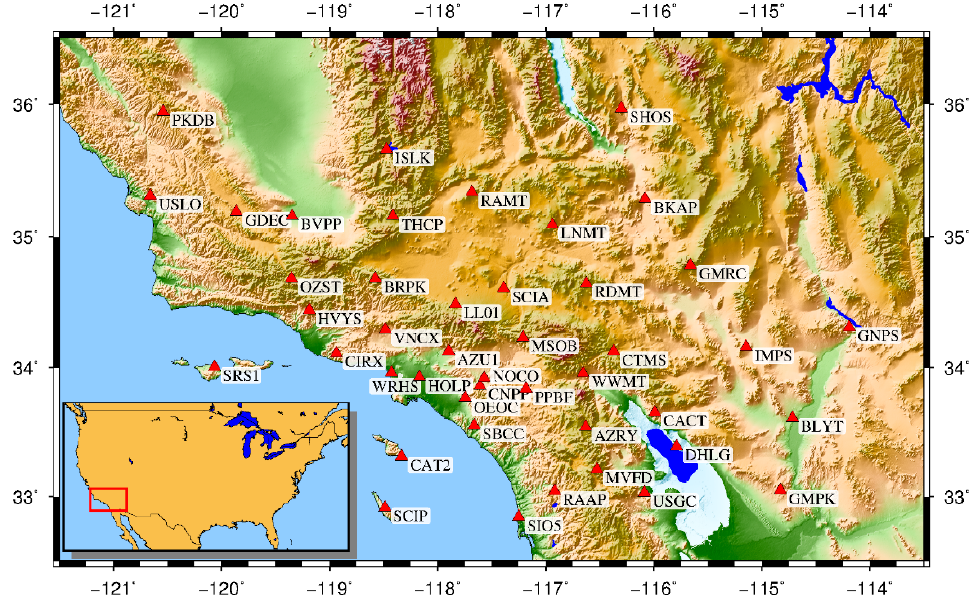
Figure 2. Geographical distribution of the selected 44 GNSS stations in Southern California.